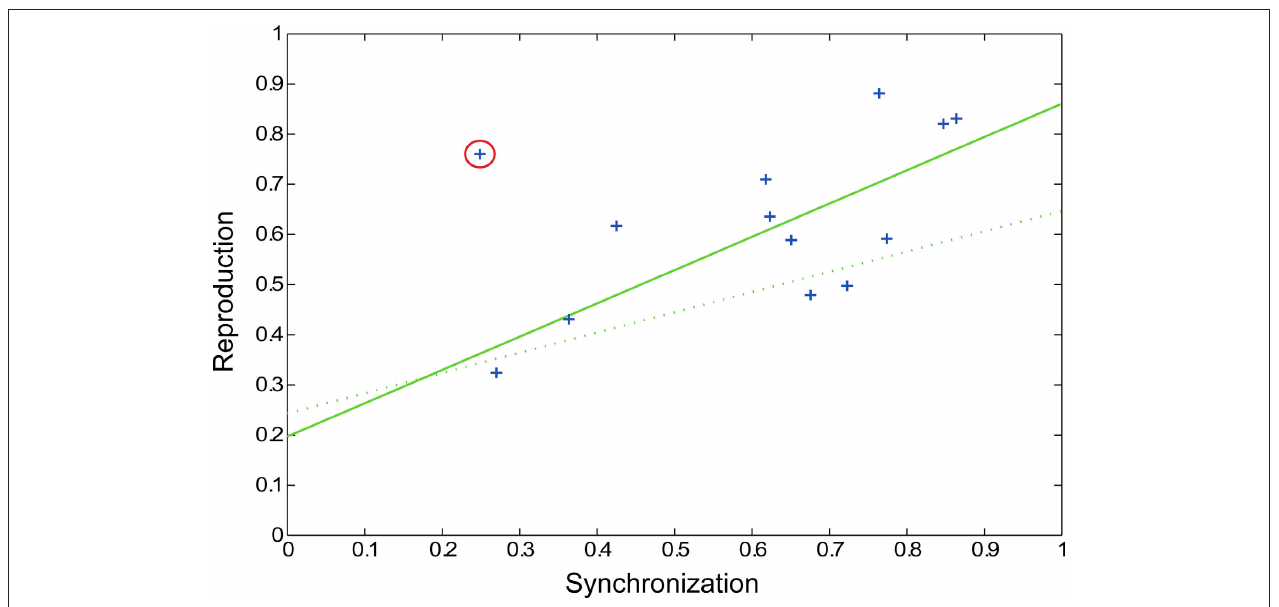
FIguRe 5 | Scatter plot showing pulse synchronization coefficients and rhythm reproduction values. Each subject’s data is represented by a blue cross, with the outlier circled in red. The solid green line represents the regression line with the outlier removed ( p = 0.0064) and the dotted green line represents the regression line with the outlier included ( p =